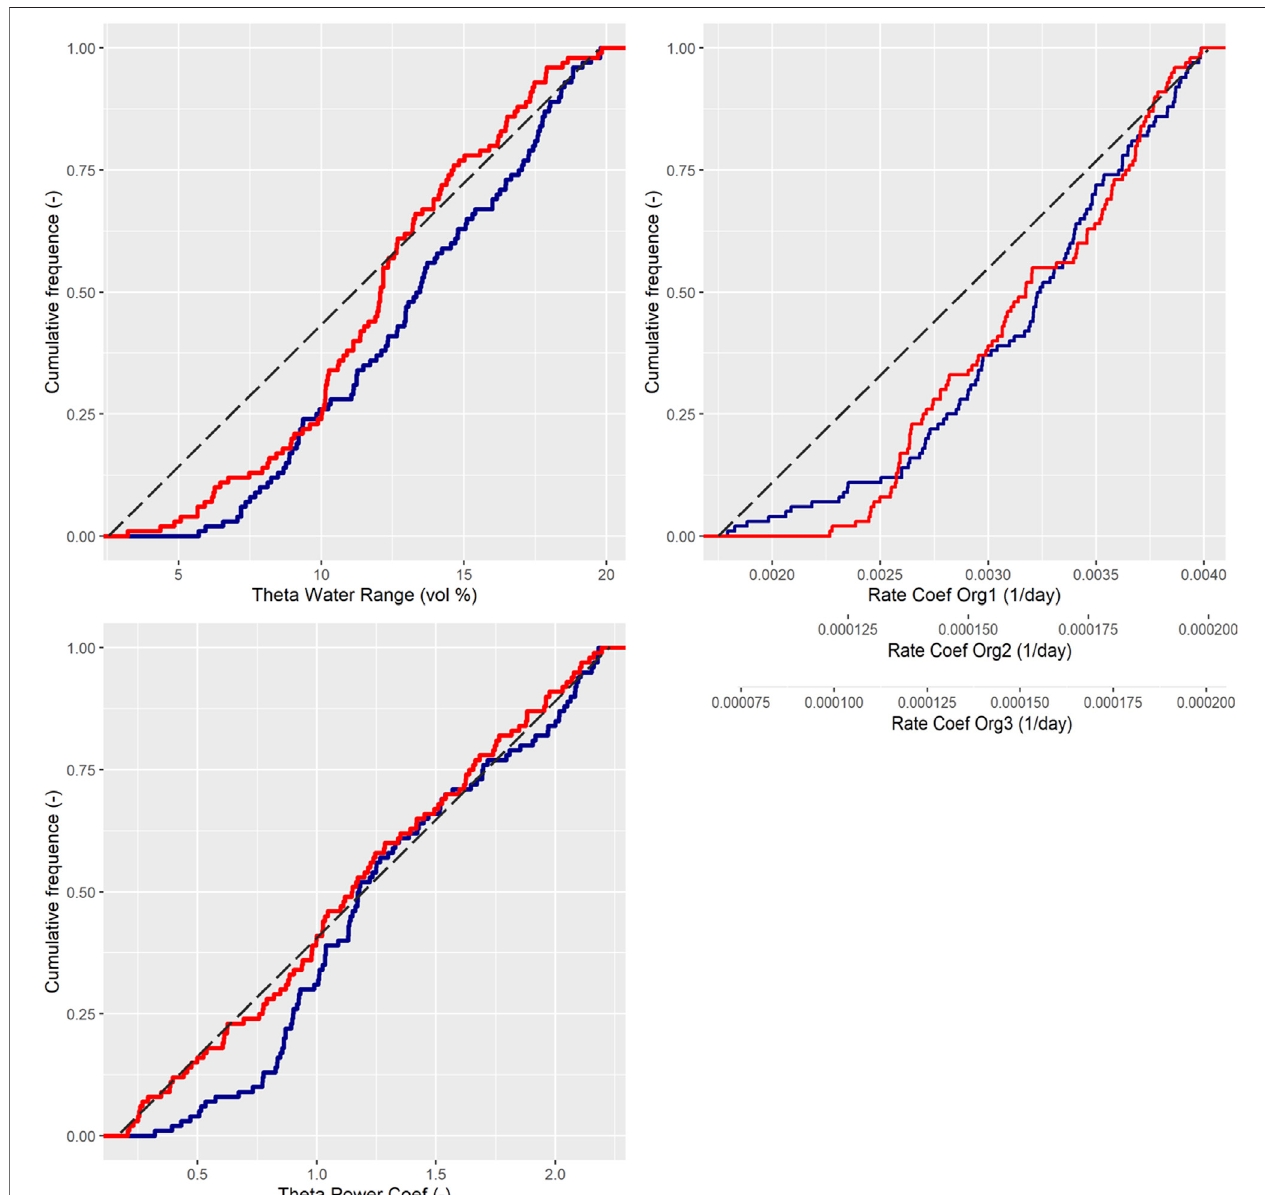
FIGURE 3 | The cumulative frequency distribution of the accepted parameter values associated with soil processes. K (cid:1) blue and L (cid:1) red.